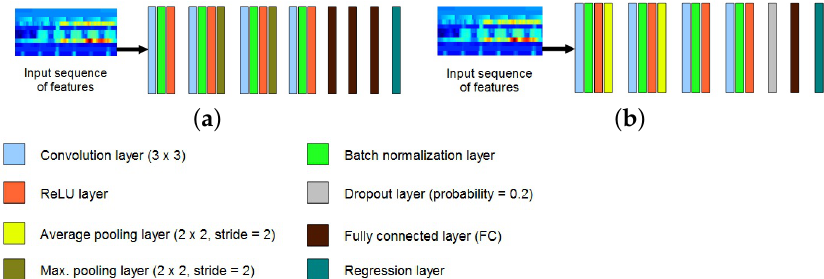
Figure 2. Proposed CNN architectures. ( a ) CNN 1 : Convolution layer #filters (from left to right): 8, 16, 32, 64. FC sizes (from left to right): 5096, 512, s ; ( b ) CNN 2 : Convolution layer #filters (from left to right): 8, 16, 32, 32. FC size: s